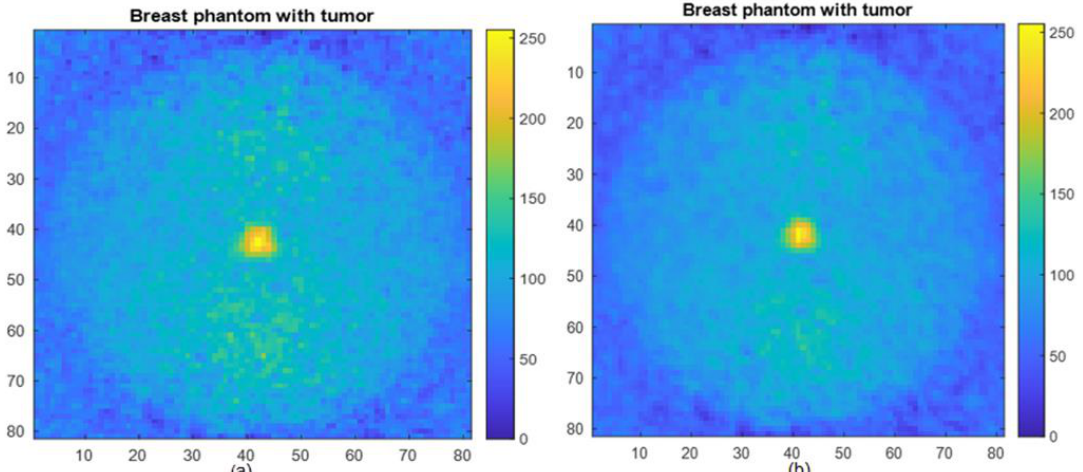
Figure 8. Reconstructed image with an 8 mm lesion: ( a ) central part, ( b ) central part added with partial copies along axial directions.